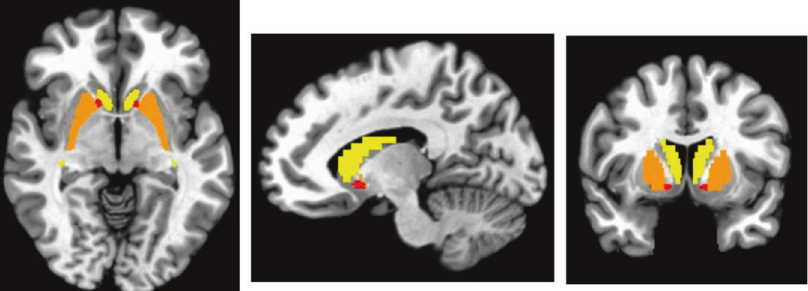
Fig. 1 Anatomically de fi ned regions of interest (ROIs) where striatal normalized T2*-weighted signal was extracted. Bilateral caudate shown in yellow, bilateral putamen shown in orange, bilateral nucleus accumbens shown in